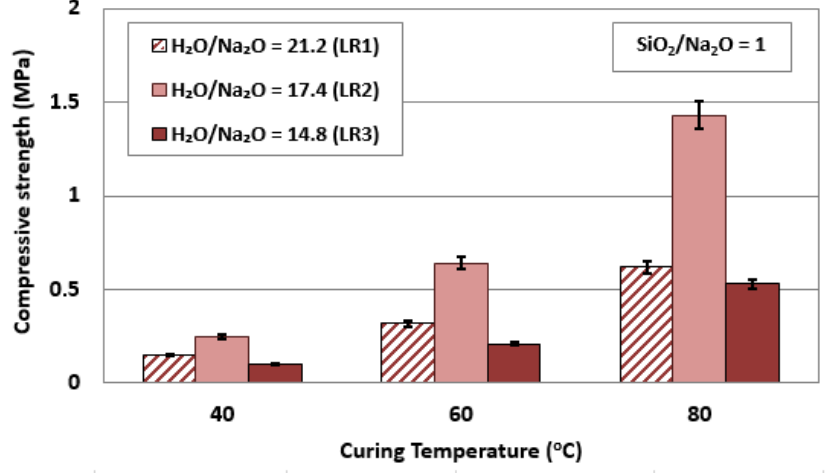
Figure 1. Effect of curing temperature in relation to H 2 O/Na 2 O molar ratios in the activating solution on the compressive strength of laterite based AAMs (pre-curing time, 4 h; curing time, 24 h; ageing period, 7 days; error bars denote standard deviation of measurements obtained from three specimens).